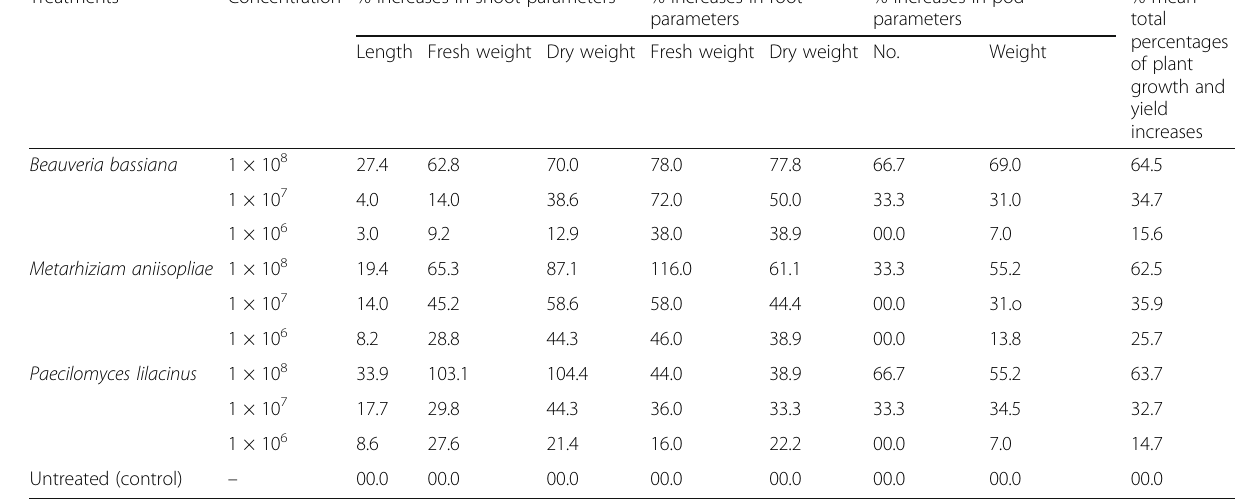
Table 11 Percentages of increase of vegetative parameters and yield of cowpea infected by root-knot nematode, Meloidogyne incognita , as affected by three spore concentrations from Beauveria bassiana , Metarhiziam aniisopliae , and Paecilomyces lilacinus Treatments Concentration % increases in shoot parameters % increases in root